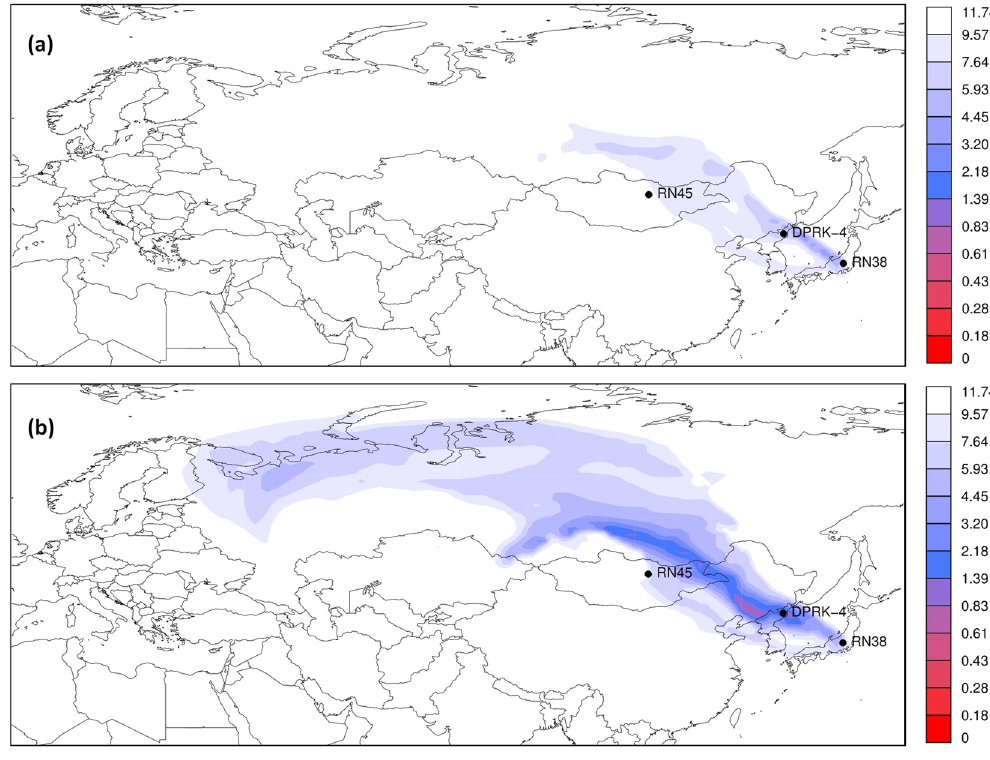
Figure 2. Map showing how well a grid box source can explain the observed 133 Xe concentrations considered in the simulations (lower values denote a better match). Results are for ( a ) Q max = 10 12 Bq/day and ( b ) Q max = 10 13 Bq/day. The numbers in the legend are the square root of the cost function (Eq. 1) and can thus be seen as a RMSE (mBq/m³). Maps have been generated using ref.